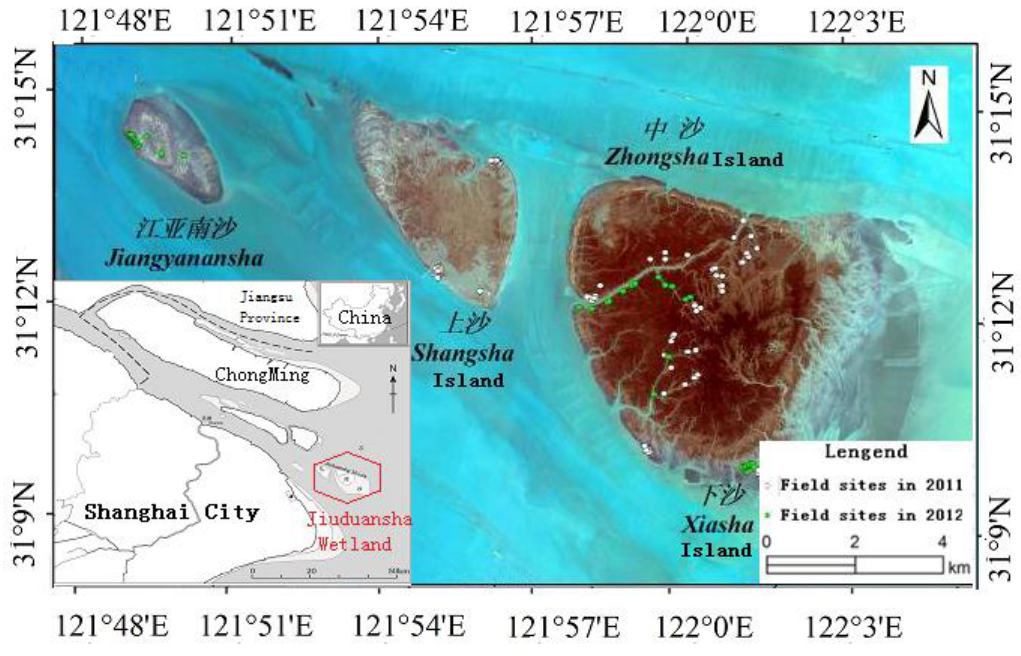
Figure 1. The True-color composite image of the study area obtained from ZY-1 02C satellite on 16 May 2012 and the spatial distribution of field observation sites (dotted